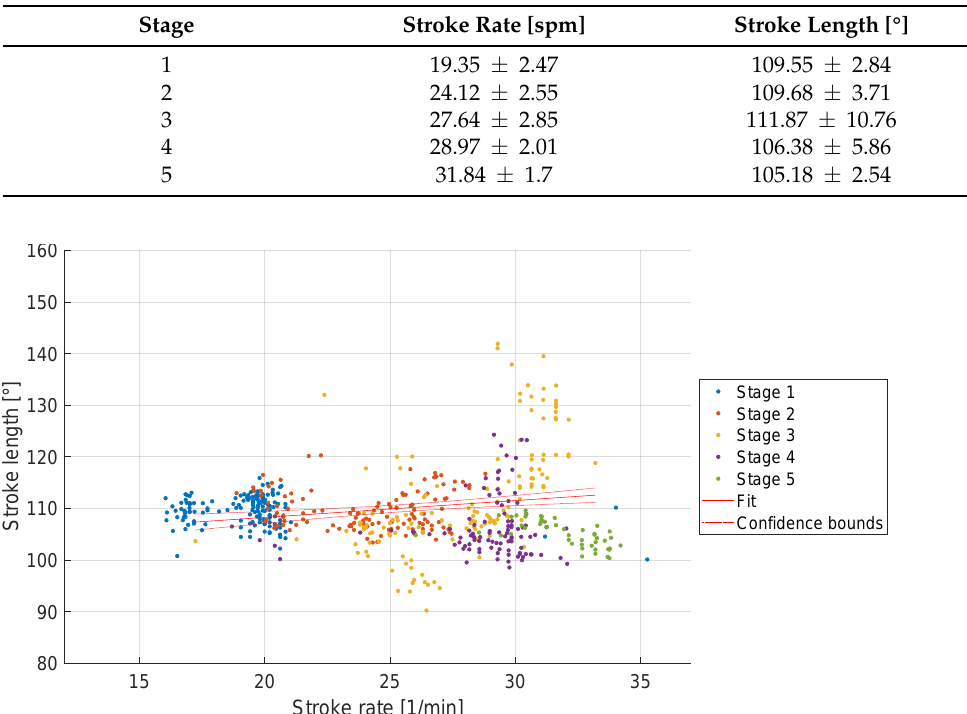
Figure 7. Stroke length and stroke rate of the rower during five load